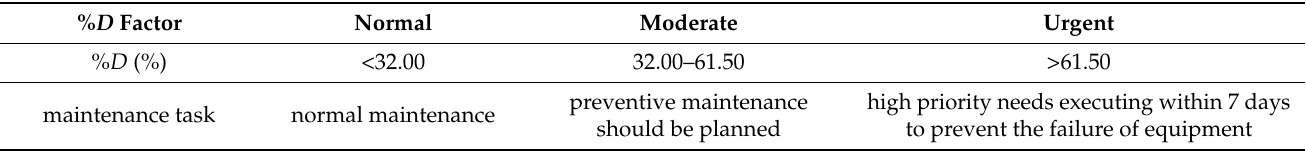
Table 7. D-Distance factor for failure probability assessment and maintenance actions.